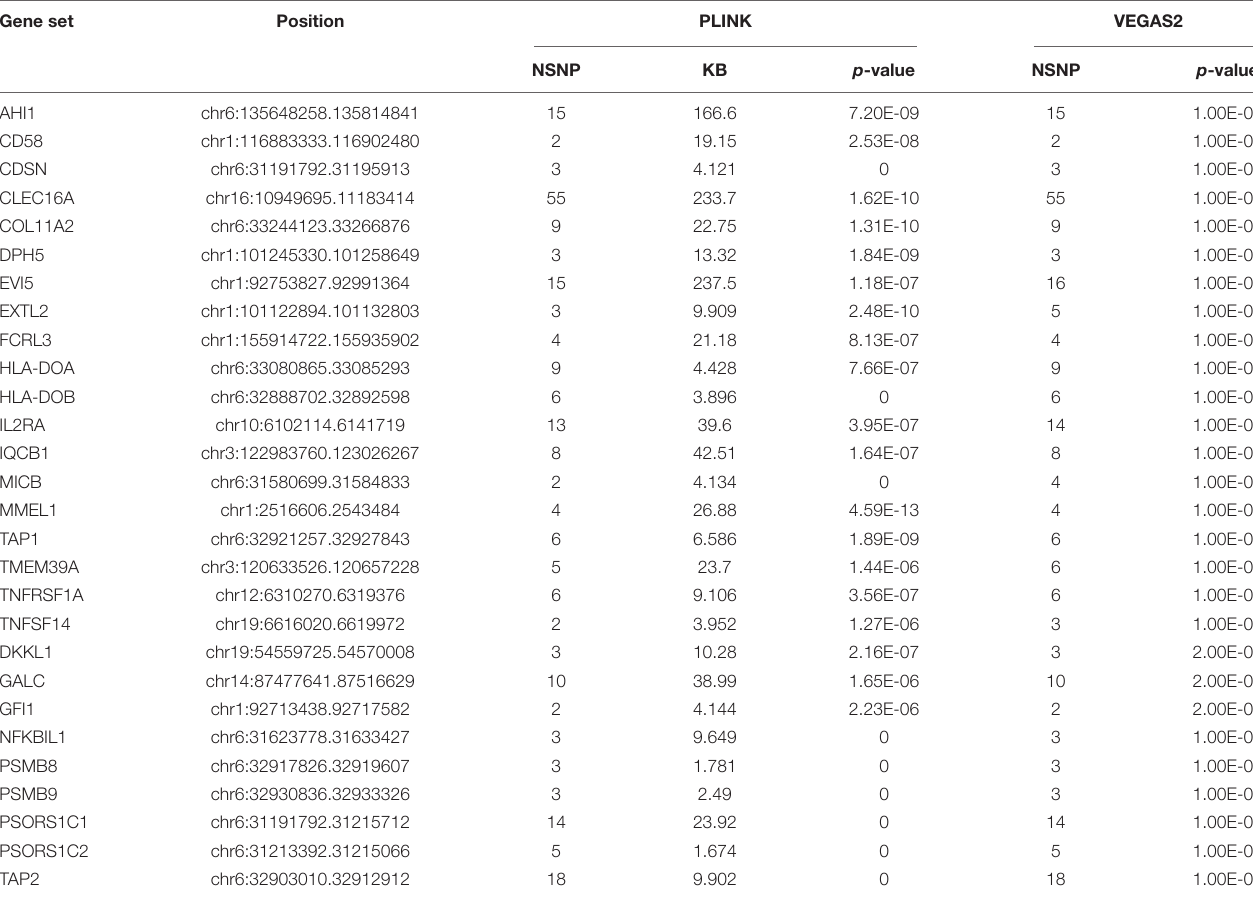
TABLE 1 | Comparison of significant shared gene sets in MS produced with PLINK and